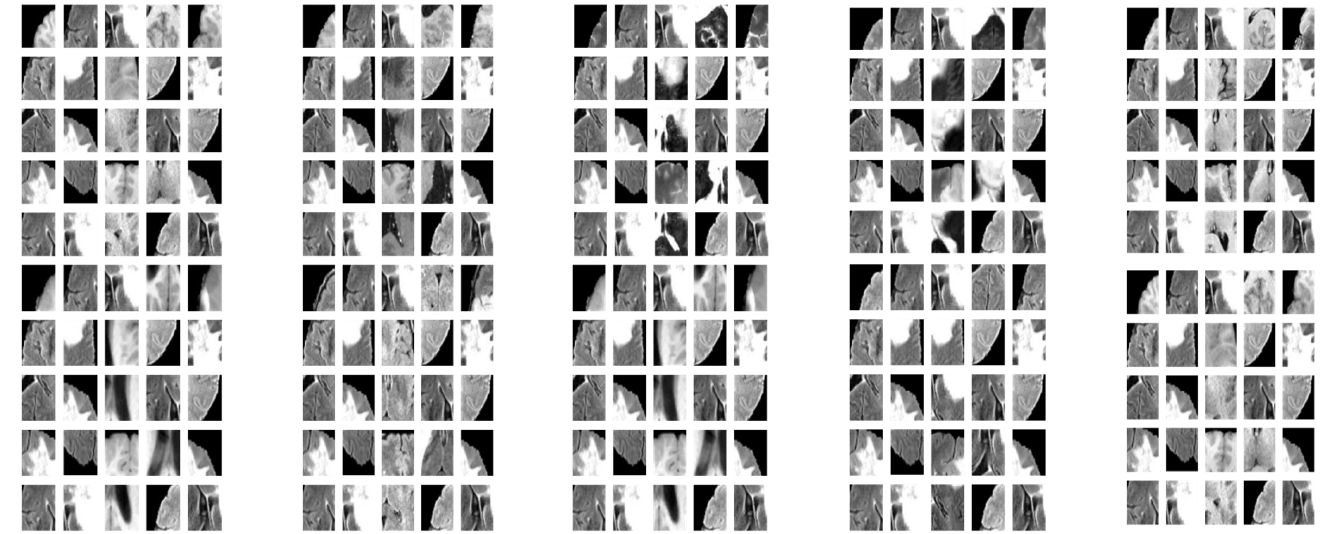
Figure 3. Sample of Extracted Patches.